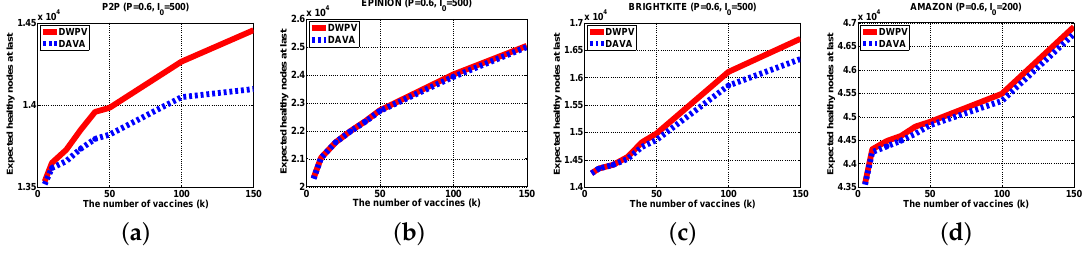
Figure 11. Experiments Results ( P = 0.6, I 0 = 500 ) . ( a ) P2P; ( b ) EPINION; ( c ) BRIGHTKITE; ( d )